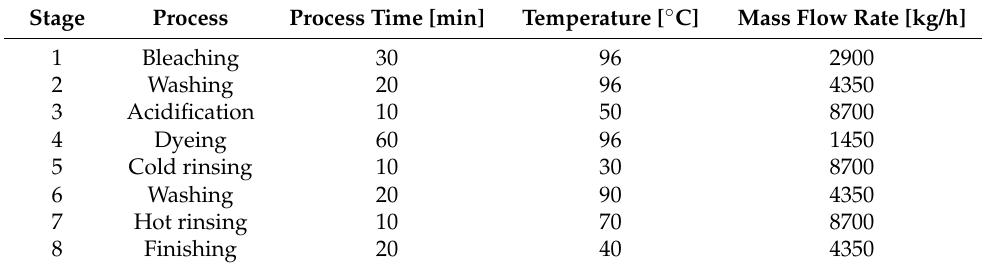
Table 1. Operating time and temperature and flow rate of discharged wastewater in each stage of the dyeing